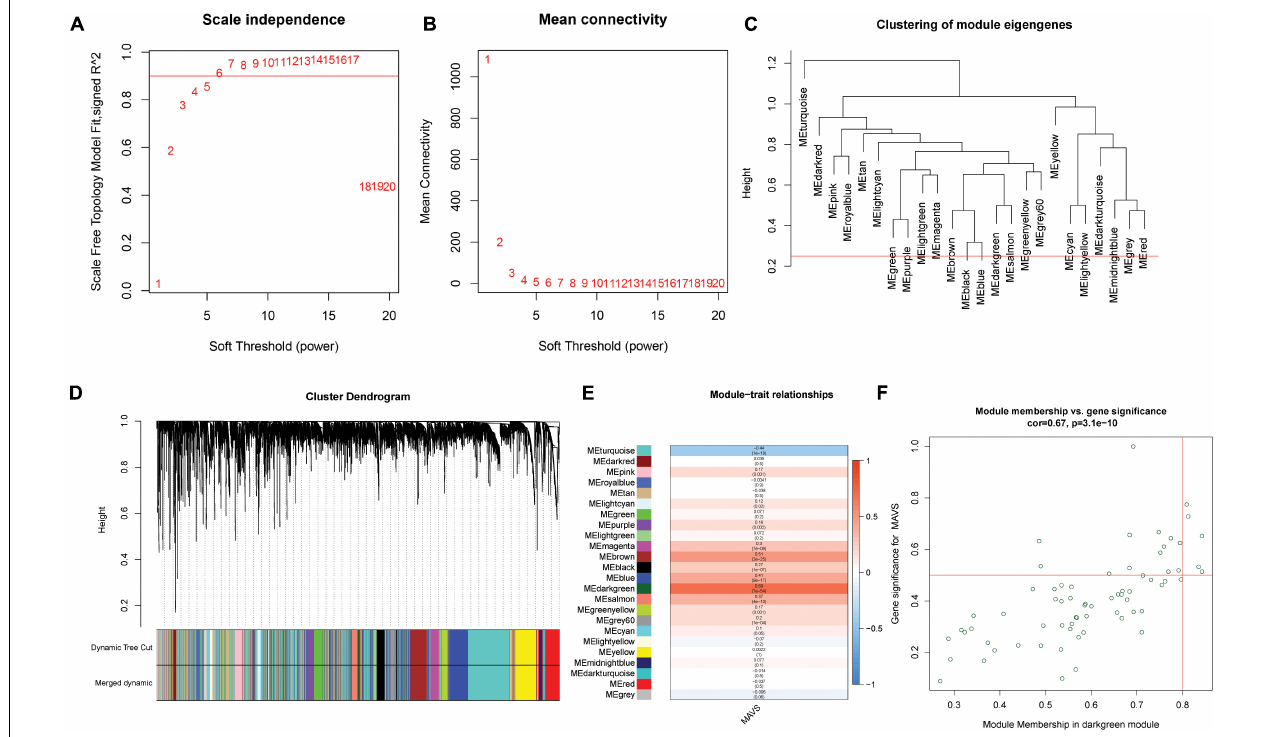
FIGURE 4 | Weighted gene co-expression network (WGCNA) analysis of MAVS-related genes in OC. (A,B) Topological network analysis of the optimal soft threshold. (C) Similar modules with correlating module eigengenes were merged to form 24 major modules based on a distance threshold cut-off of 0.25. (D) Heat map of the correlations between the 24 modules and two different MAVS expression groups. (E) Correlation analysis of modules and traits. Dark green module showed maximum correlation with positive MAVS expression traits. (F) Intramodular analysis of 69 genes that has the most significant correlations with MAVS expression in the dark green module (correlation = 0.69, P =